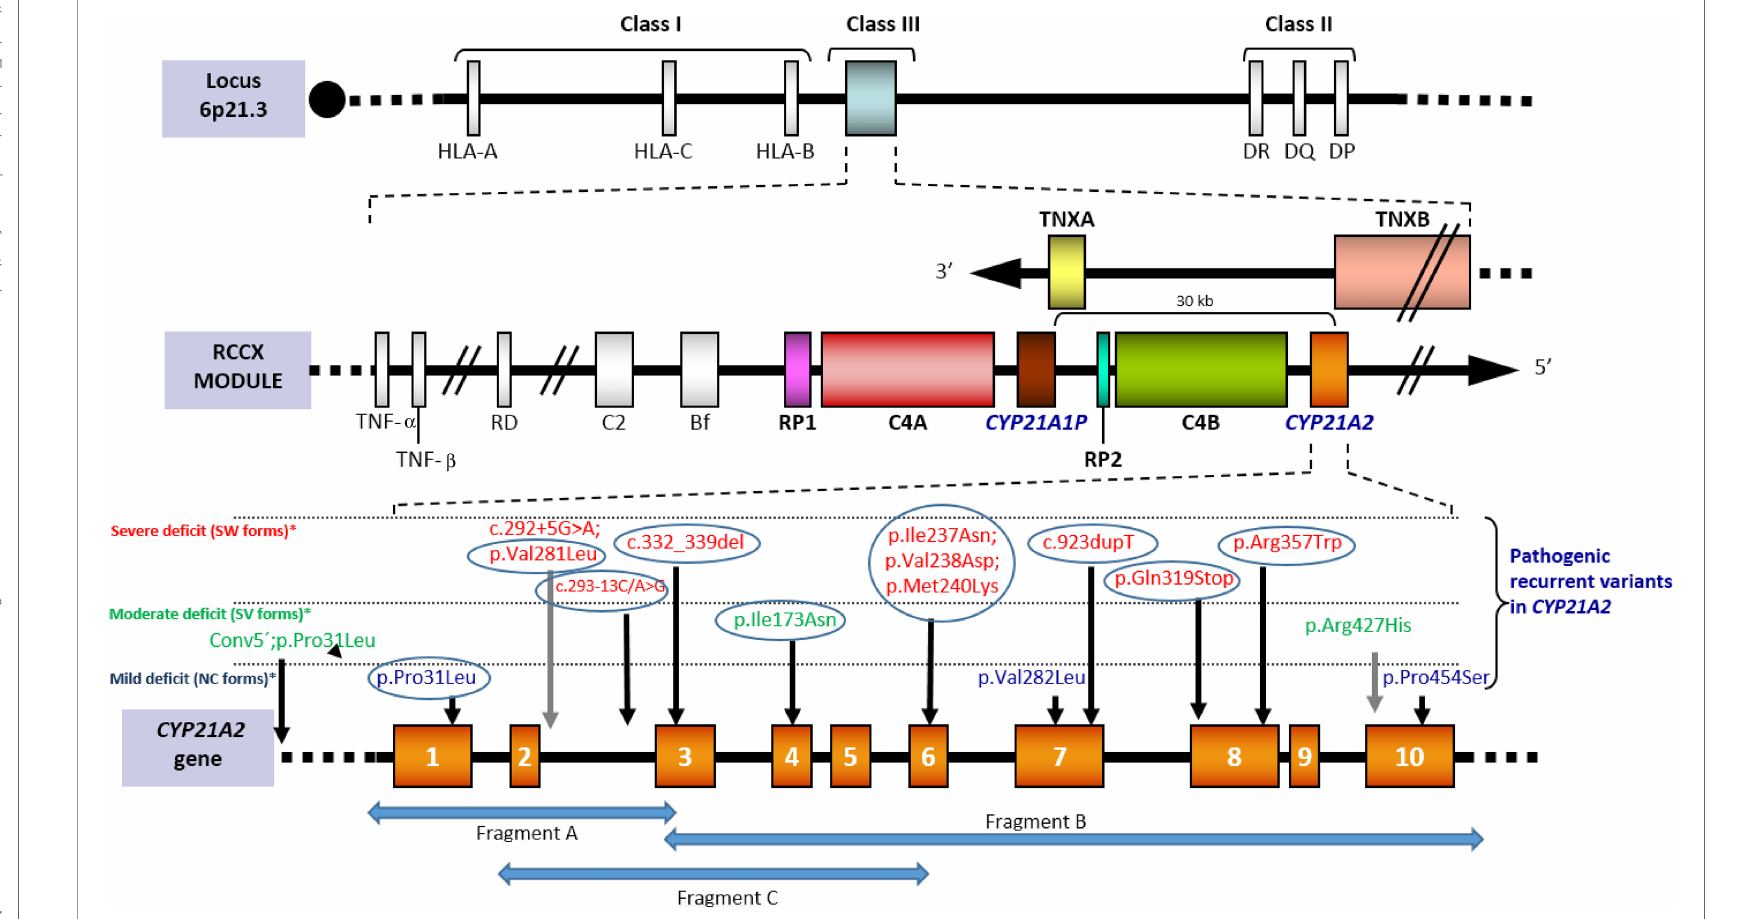
FIGURE 1 | [Adapted from Santome ́ et al., (21)]. Scheme of the RCCX module located on the short arm of chromosome 6 within the HLA class III region. Tandem duplication affects CYP21 and C4 genes. In humans only CYP21A2 gives rise to the functional protein, whereas CYP21P is a homologous pseudogene that includes several inactivating point variants that can be transferred to the active gene by small gene conversion events. Both C4A and C4B are functional. Tenascin, also duplicated, is encoded in the complementary chain. The bottom of the image shows the recurrent variants grouped according to how they affect the enzimatic functionality: severely (red), moderately severe (green) or mildly (blue). Recurrent variants in all populations are circled. The complete nomenclature of each variant including the cDNA position (NM_000500.9) would be: c.92C>T [p.Pro31Leu], c.292+5C>A, c.293-13C>G, c.332-339del, c.518T>A [p.Ile173Asn], c.(710T>A; 713T>A; 719T>A) p.[Ile237Asn; Val238Glu; Met240Lys], c.844G>T [p.Val282Leu], c.923dupT, c.955C>T [p.Gln319*], c.1069C>T [p.Arg357Trp], c.1280G>A [p.Arg427His] and c.1360C>T [p.Pro454Ser]). The arrows “ Fragment A ” , “ Fragment B ” and “ Fragment C ” represents speci fi c amplicons for CYP21A2 ampli fi